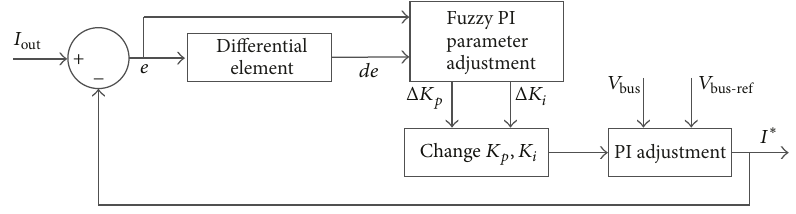
Figure 6: Fuzzy controller. Table 2: Rule table of 𝐾𝑖 parameter fuzzy control.